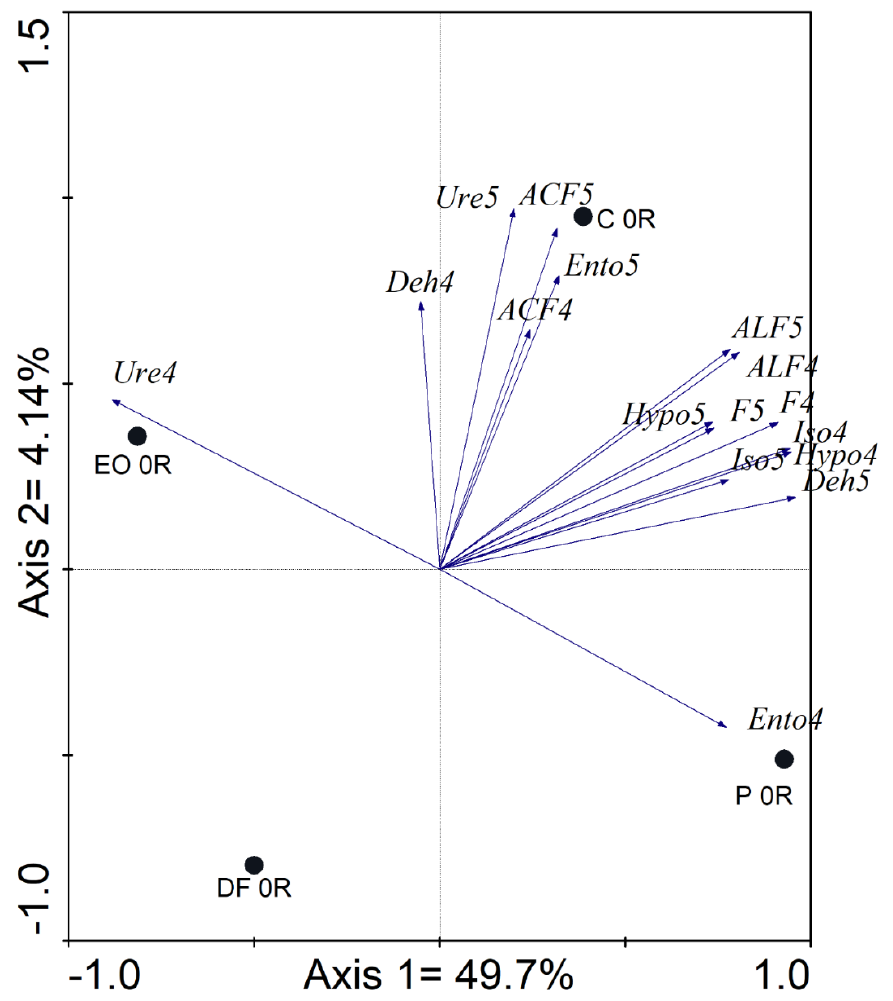
Figure 6. Principal component analysis of soil enzyme activity and soil fauna occurrence in soils